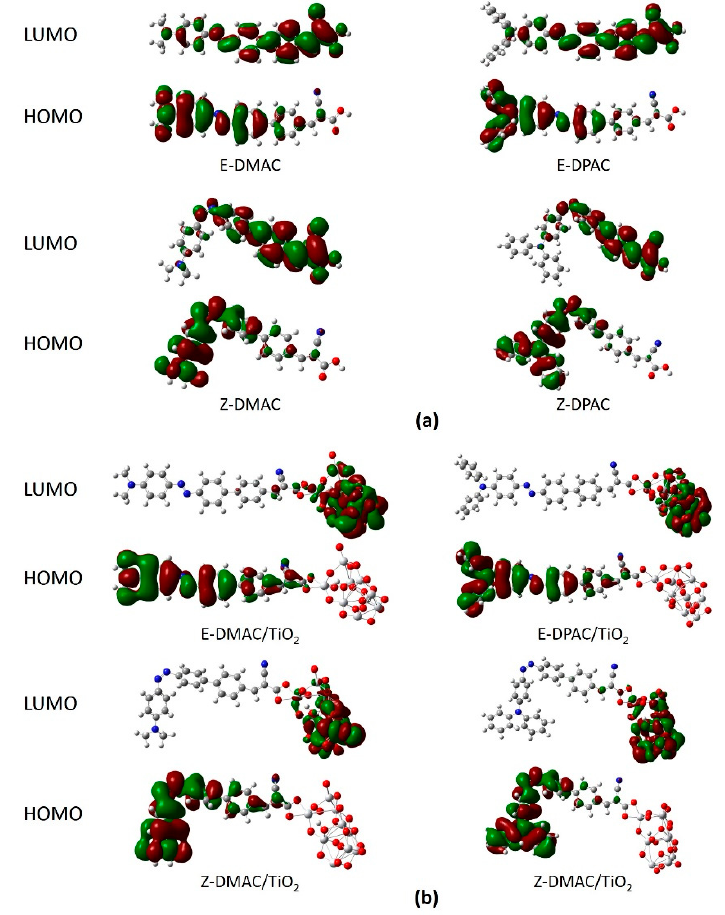
Figure 3. Frontier molecular orbitals of trans and cis isomers of DMAC and DPAC as ( a ) isolated dyes and ( b ) dye/TiO 2 complexes.